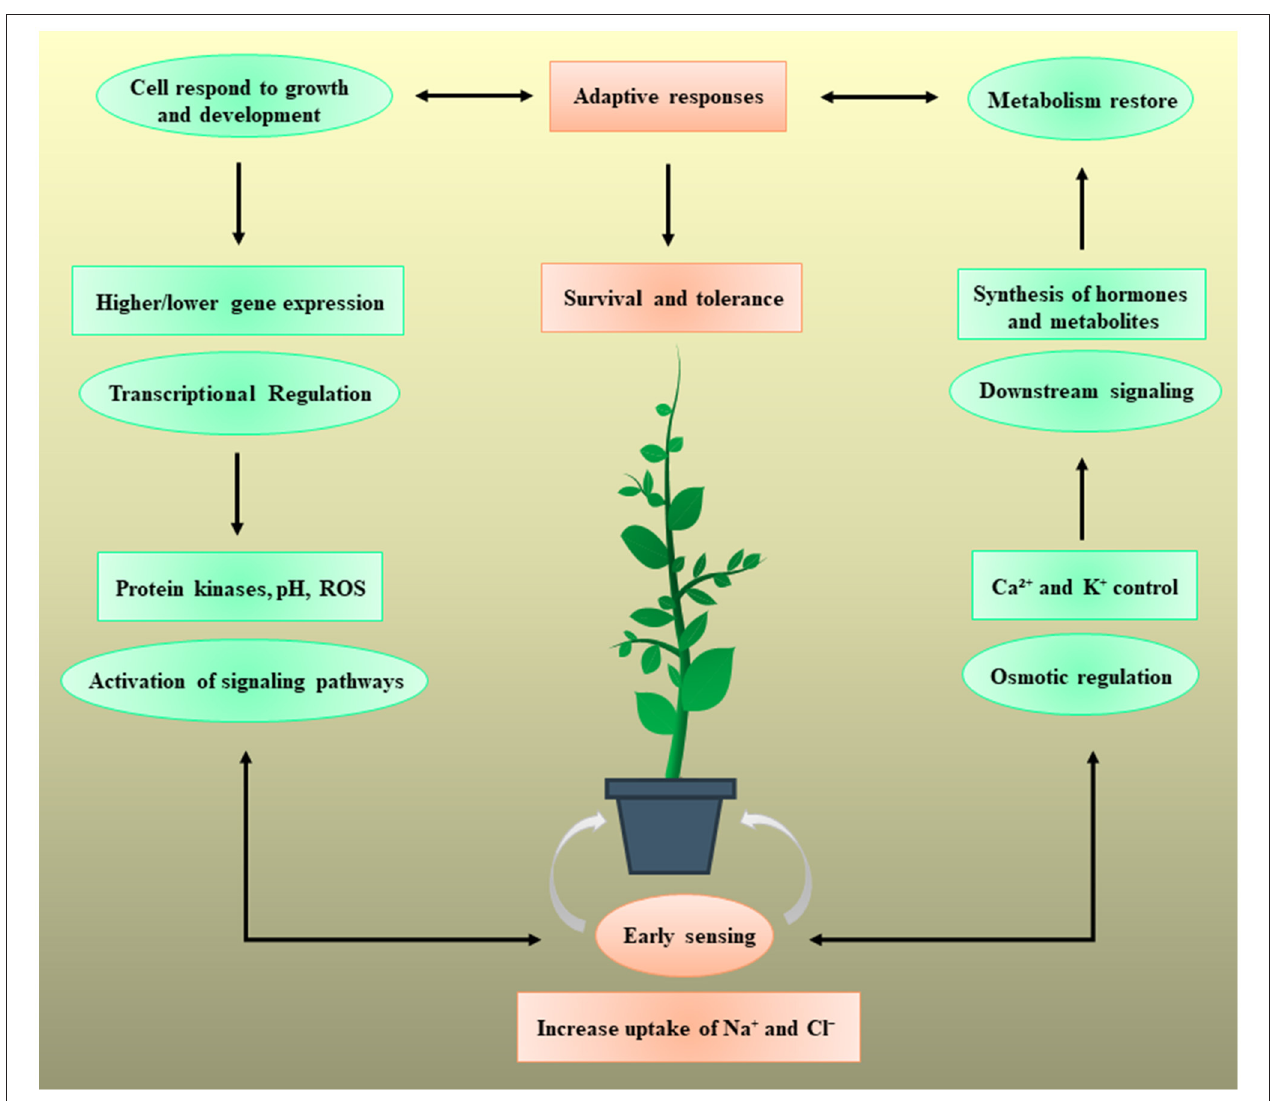
FIGURE 1 | Plants respond to salt stress by triggering different regulatory mechanisms and assist the plants for their survival. The Na + and Cl − bring particular downstream responses, but the plant sensing systems are not yet fully understood. The mechanism could start with the early sensing of Na + import intracellularly or extracellularly. This early sensing induces the different osmotic and regulatory pathways including protein kinase activity, reactive oxygen species (ROS), pH balance, H + transport, and Ca 2 + and K + signaling. These early sensing mechanisms reduce the Na + import and initiate the downstream signaling pathways to activate the transcriptional machinery which may increase or decrease the expression of certain stress-responsive genes. It also causes significant difference in the concentration, synthesis, and transport of unique hormones and metabolites. Finally, the adaptive response aids the plant cells to bypass the salinity stress by modulation of growth and metabolism. Each step of salt inducive mechanism plays a vital role in providing the salinity tolerance and survival to the